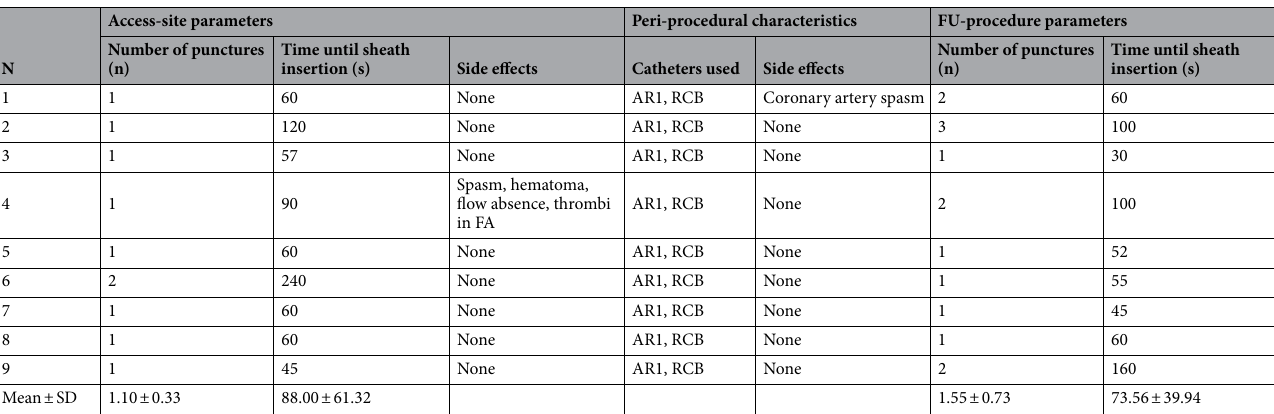
Table 1. Periprocedural characteristics. FA femoral artery, FU